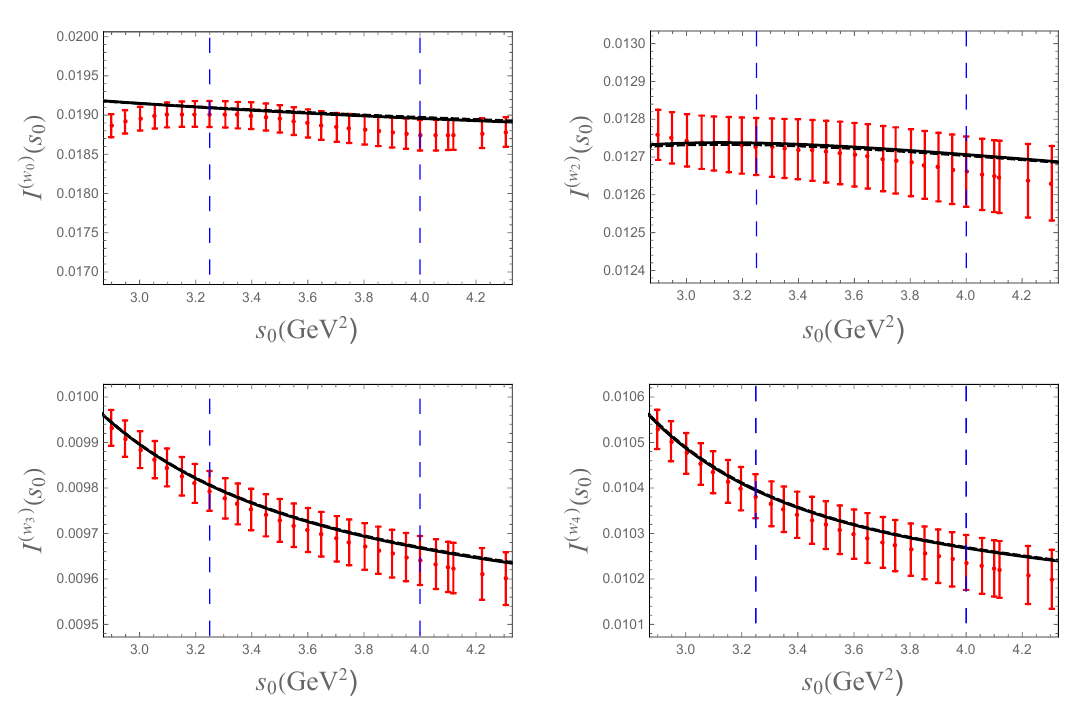
) with the fits on the interval s min 0 (upper left panel), w = w (upper right panel), w = w 0 2 (lower right panel). Solid black curves indicate FOPT fits, 4